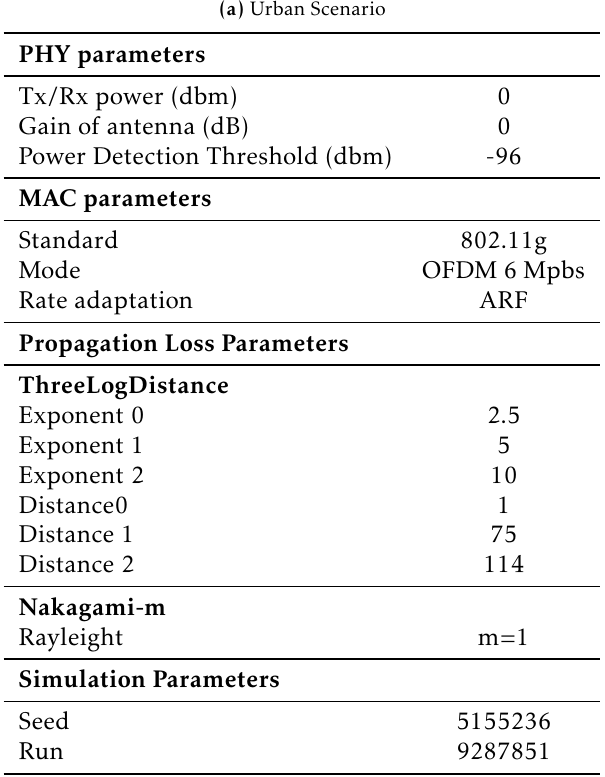
Table 2. Simulationparameters